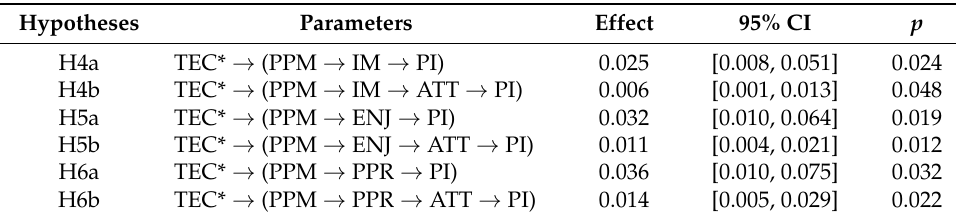
Table 4. Moderating effect of